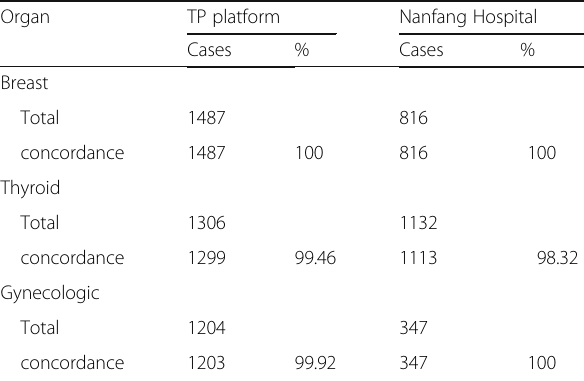
Table 4 The comparison of concordance rate in different body systems between cases from the TP platform and from Nanfang Hospital